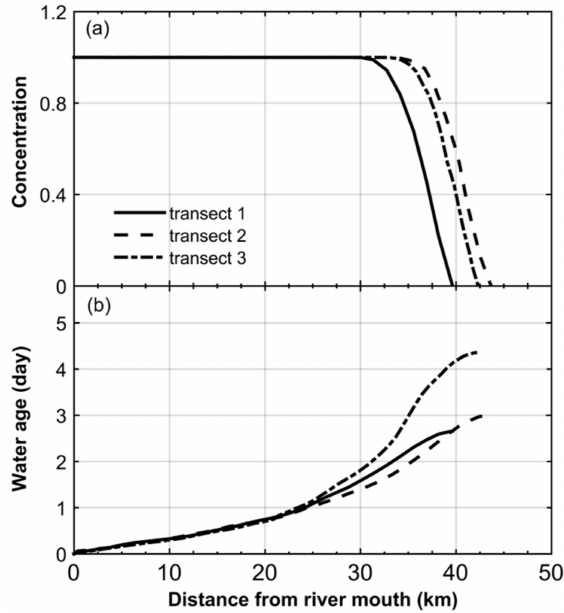
Figure 5. Calculation results of: ( a ) concentration and ( b ) water age during the high flow period, along the three considered transects (see Figure 3) for the case of the river